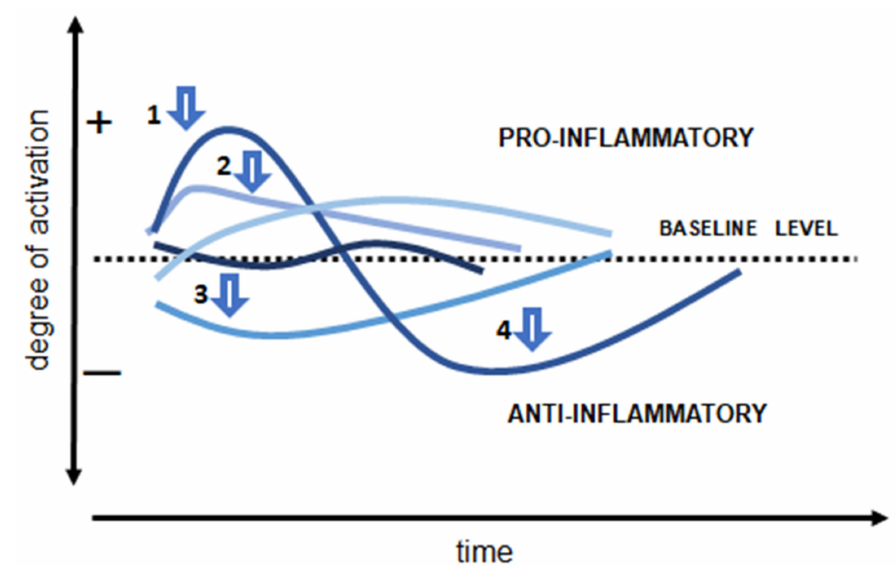
Figure 1. Each patient follows their own trajectory of immune response activation during the course of sepsis, rather than all following the same pattern. The early response is usually proinflammatory and the later response immunosuppressive, but there are exceptions, and the time course can vary substantially from one patient to the other. The arrows indicate some examples of time points at which an anti-inflammatory strategy may be beneficial (1 and perhaps 2) and others when it may be harmful (3 and